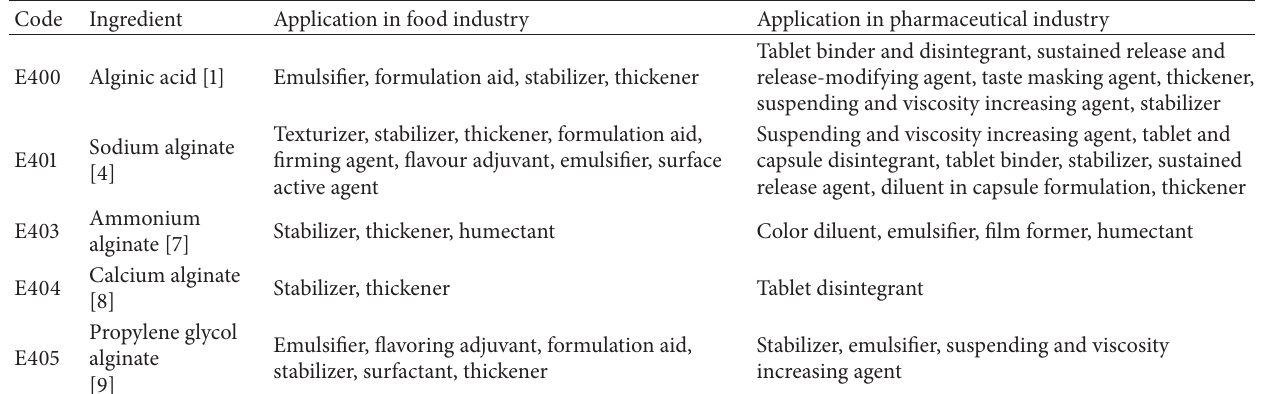
Table 2: The use of alginic acid and its salts in food and pharmaceutical